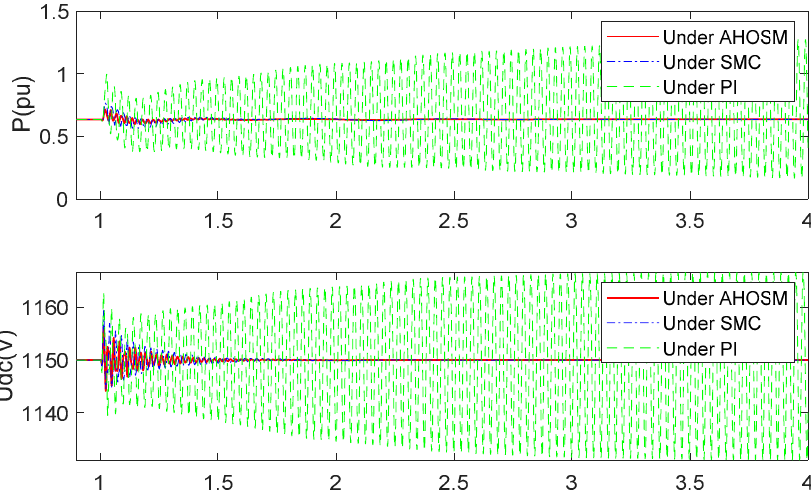
Figure 16. Responses of active power and DC link voltage under three control methods with series ‐ compensated level 70% and wind speed 11 m/s.